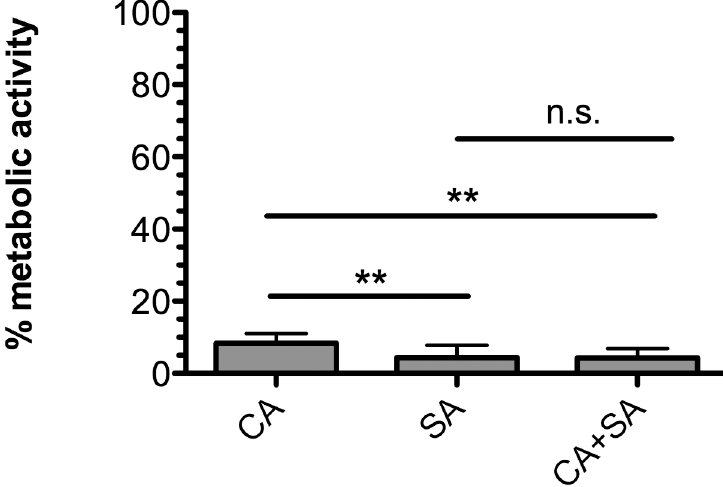
Fig 6. Treatment of mature C . albicans and S . aureus polymicrobial biofilms on silicone disks with OS 1. Monomicrobial (CA, SA) and polymicrobial (CA+SA) biofilms of C . albicans and S . aureus were challenged with drug free (DF) or optimized solution (OS 1, 20% ethanol, 800 μ g/mL doxycycline, and 0.015625 μ g/mL micafungin) prepared in sterile growth medium for 24 hours. Metabolic activity was assessed using the XTT assay and reported as % inhibition of the drug-free control. Error bars represent SDs. Data is cumulative of 4 independent experiments performed in triplicate. ** , P (cid:3) 0.01, n.s., not significant using a one-way ANOVA and Tukey ’ s multiple comparisons post-test.